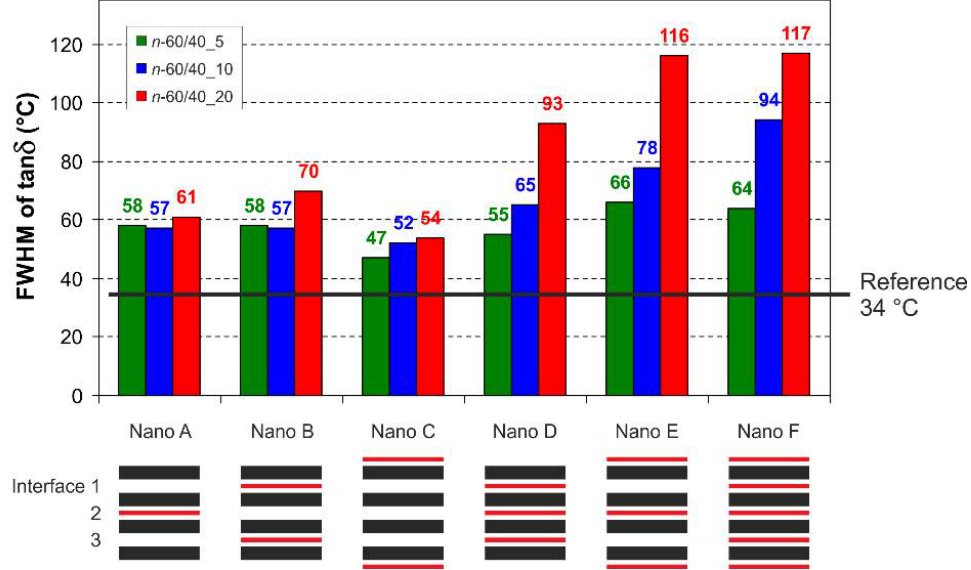
Figure 10. Comparison of Full Width at Half Maximum (FWHM) of tanδ peaks (standard deviations, not reported, are not higher than 3 °C in all the cases).